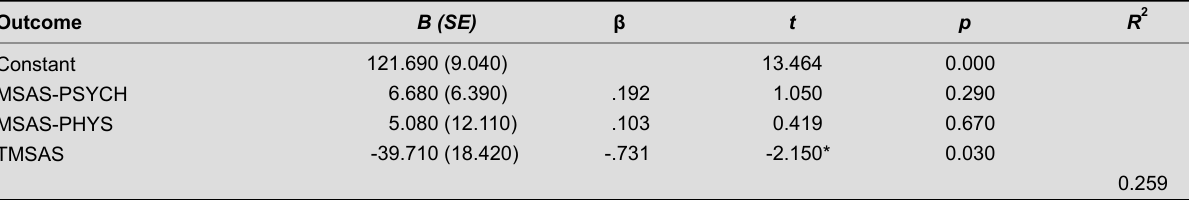
MSAS Symptoms Domains as Predictors of Quality of